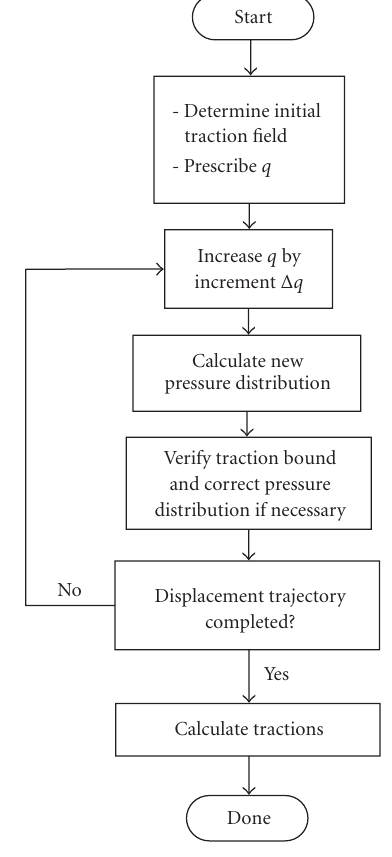
Figure 8: The flowchart of the